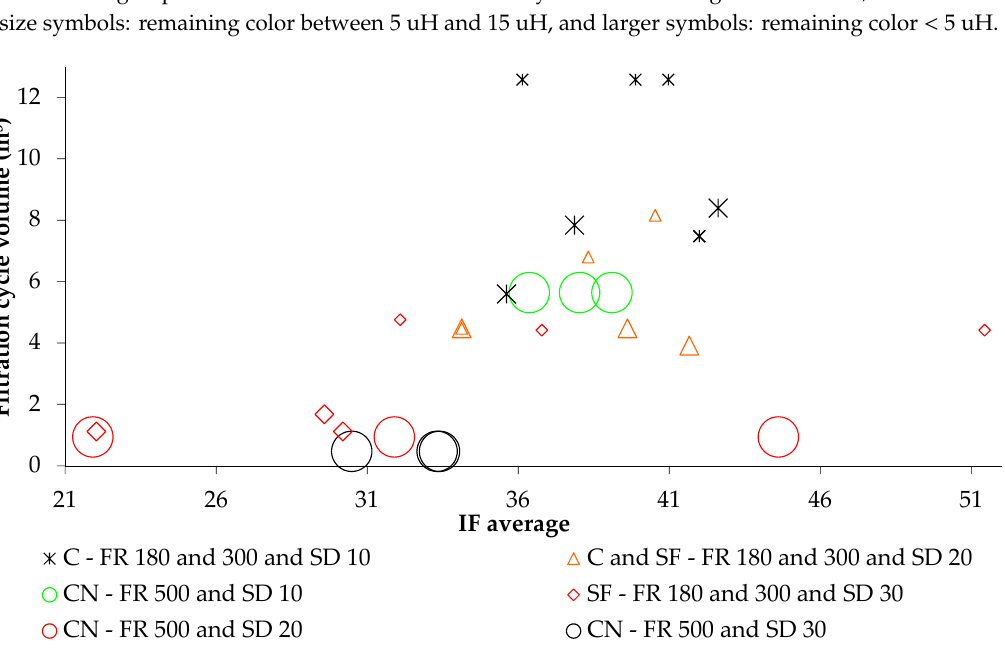
Figure 10. Filtration cycle length in relation to FI under different coagulation mechanisms and aluminium sulfate dosages.